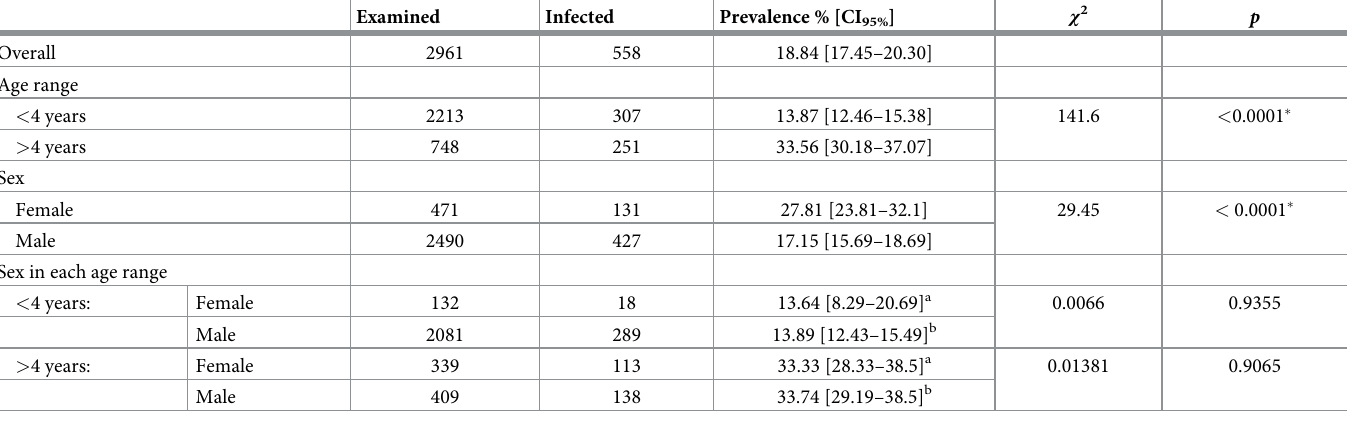
Table 1. CE prevalence by sex and age, in cattle slaughtered Santiago,